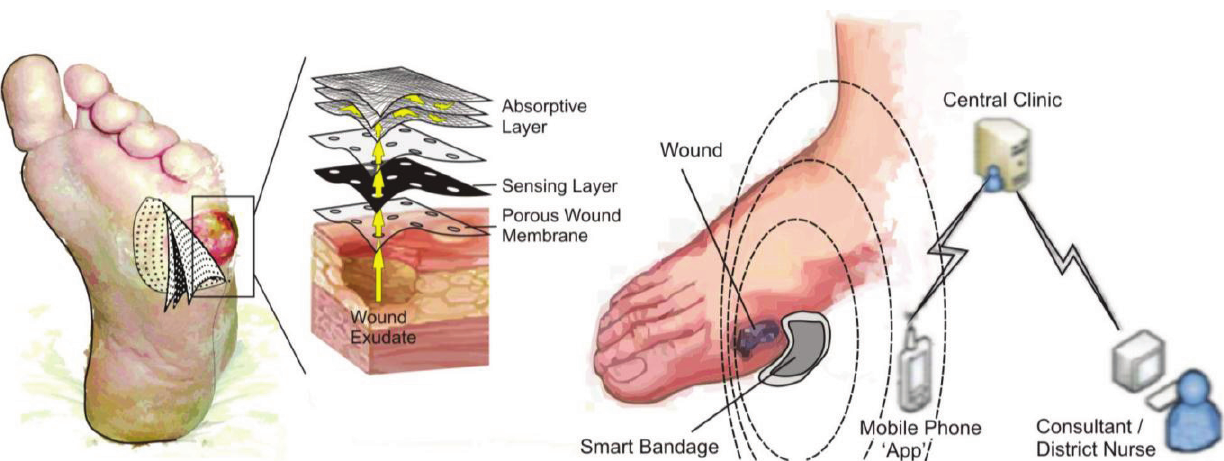
Figure 3. The proposed implementation and operation of a smart bandage based on a carbon fibre sensing layer onto which polytryptophan had been